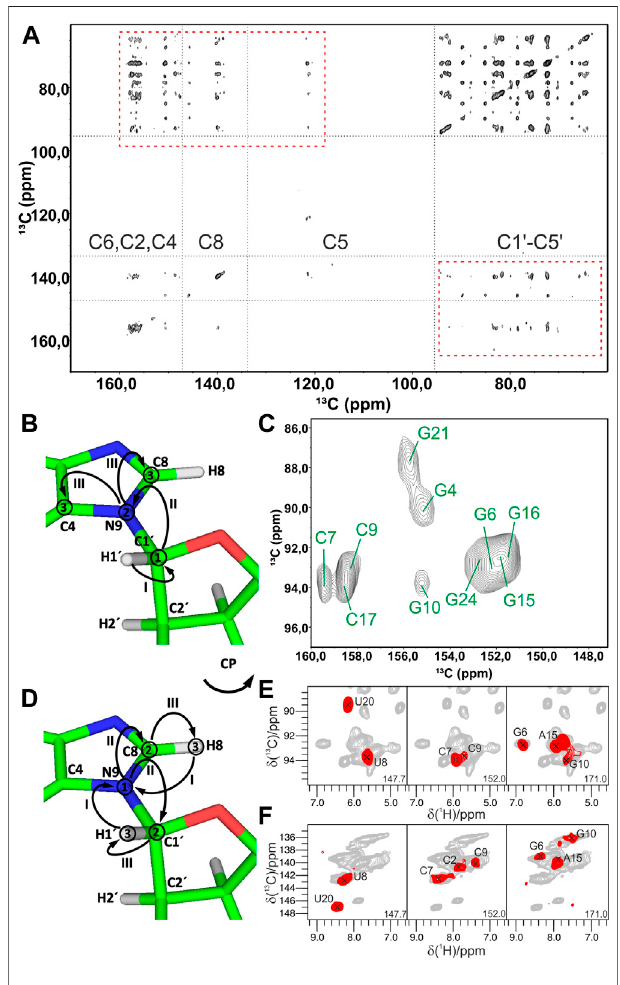
FIGURE 5 | Experiments for the ribose – nucleobase correlations. (A) 13 C, 13 C PDSD spectrum of the A lab -26mer box C/D RNA measured at 500 ms PDSD mixing time. Ribose – base cross-peaks are highlighted by rectangles. (B,C) 13 C-detected 3D CNC experiment. (B) Magnetization transfer in CNC experiment shown on the example of a purine; (C) 2D C ribose – C base projection of the 3D CNC spectrum of G,C lab 26mer box C/D RNA. Spectra in fi gures (A,C) were acquired on a 700 MHz spectrometer at 13 kHz MAS. (D – F) 1 H-detected 3D (H)NCH experiment. (D) Magnetization transfer shown on the example of a purine. (E,F) Representative 13 C – 1 H cross-sections from the (H)NCH spectra show either ribose N1/N9 – C1 ′ – H1 ′ (E) or base N1 – C6 – H6/N9 – C8 – H8 (F) correlations. 15 N frequencies are indicated in each panel. (H)NCH spectra were recorded on a 1 GHz spectrometer at 111 kHz MAS. In magnetization transfer schemes, solid arrows indicate CP transfers; Arabic numbers correspond to the spectral dimensions (t 1 – t 3 ); Roman numbers indicate CP transfers. Figures (A,C) are adapted with permission from (Marchanka et al., 2013), © John Wiley and Sons,2013.Figures (E,F) arereproducedfrom(Marchankaetal.,2018b)with permission from the Royal Society of